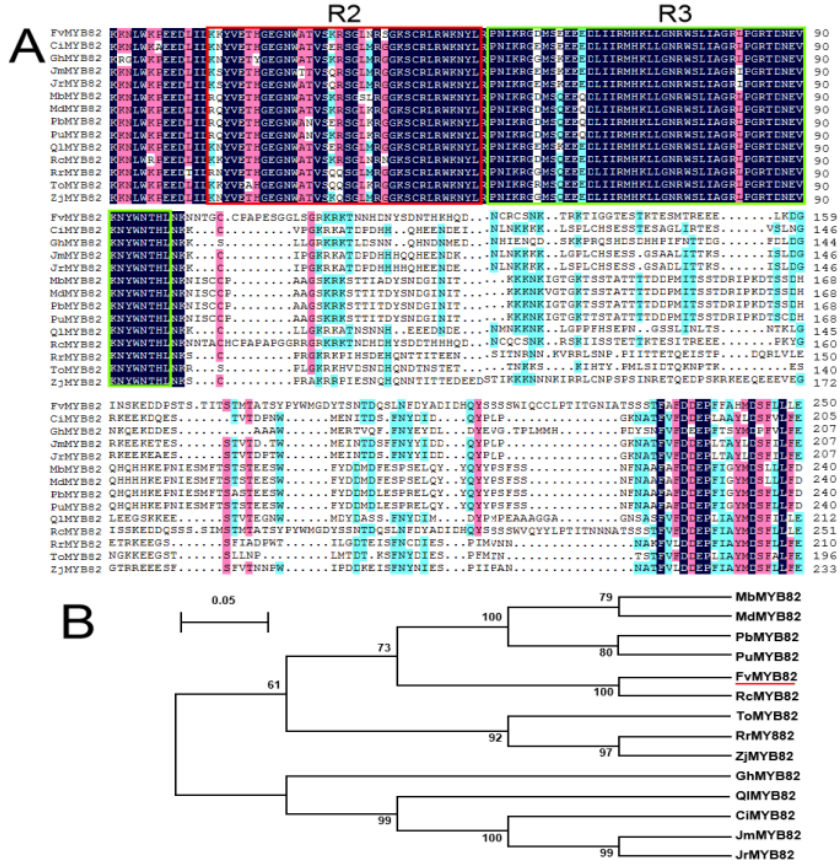
Figure 1. Contrast and evolutionary relationship between FvMYB82 and MYB transcription factors of different varieties. ( A ) Comparison between homology of FvMYB82 protein and MYB protein in other plants. The conserved regions of the amino acid sequence are marked by black and red boxes. ( B ) Phylogenetic tree analysis of MYB protein in FvMYB82 and other plants. The